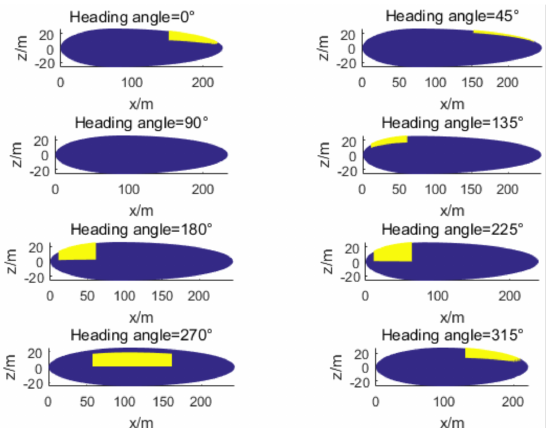
Figure 15. The optimized shape of airship (side view) for different heading angles.